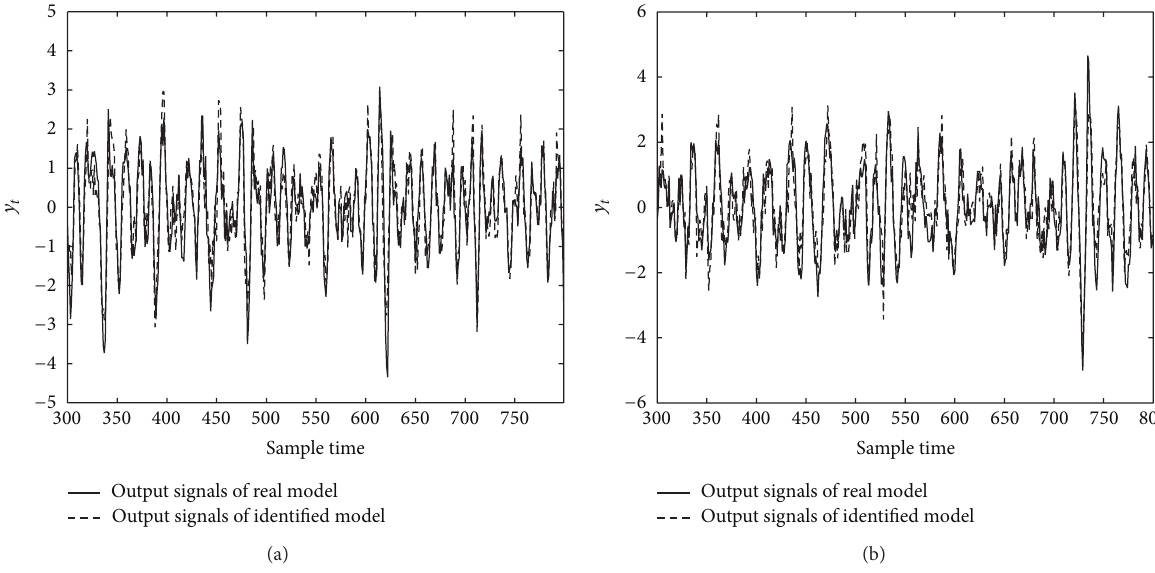
Figure 3: Output signals of identified model comparing with actual model. (a) 𝑏 = 3 , 𝑙 = 5 ; (b) 𝑏 = 5 , 𝑙 = 3